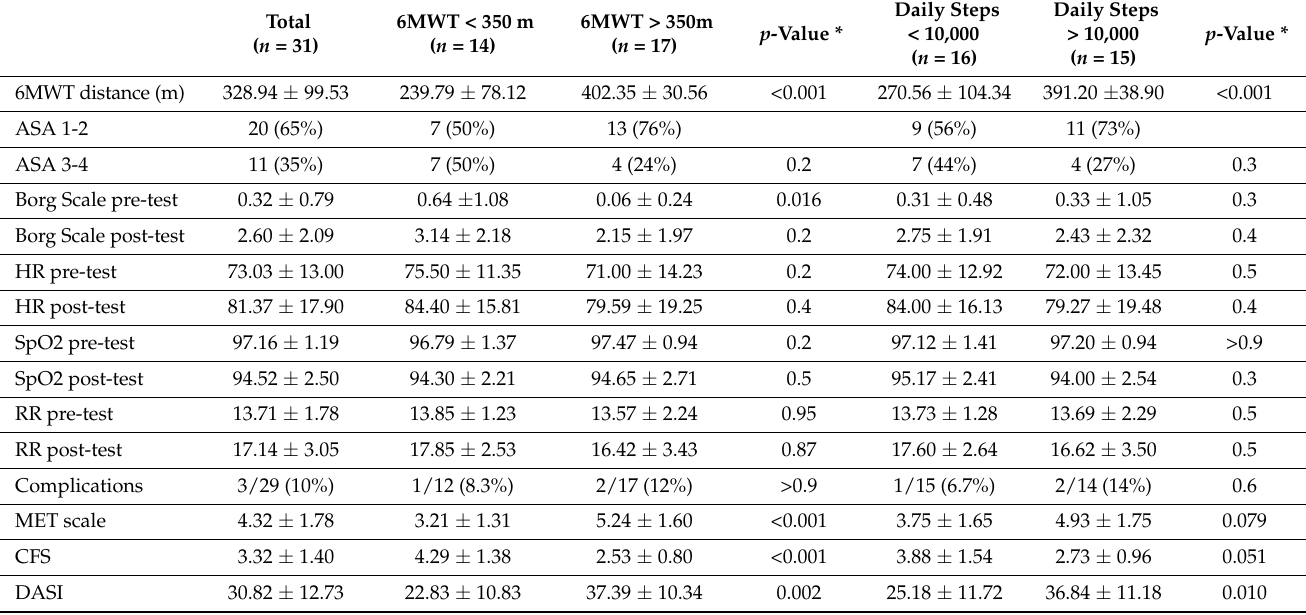
Table 2. Total daily steps, 6MWT performance data, preoperative evaluation scales, and patient characteristics according to 6MWT threshold and to WD daily steps threshold.